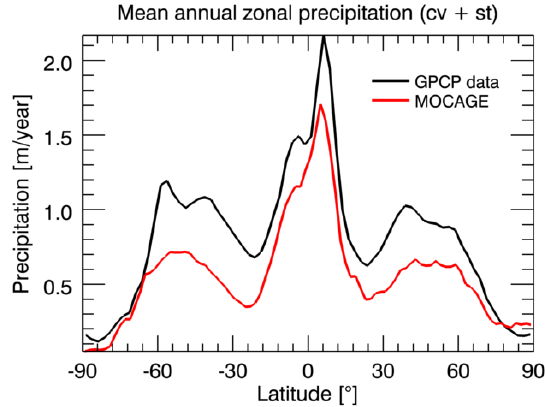
Figure 11. Mean annual zonal precipitation quantity (combined stratiform (st) and convective (cv) precipitation) from GPCP data and